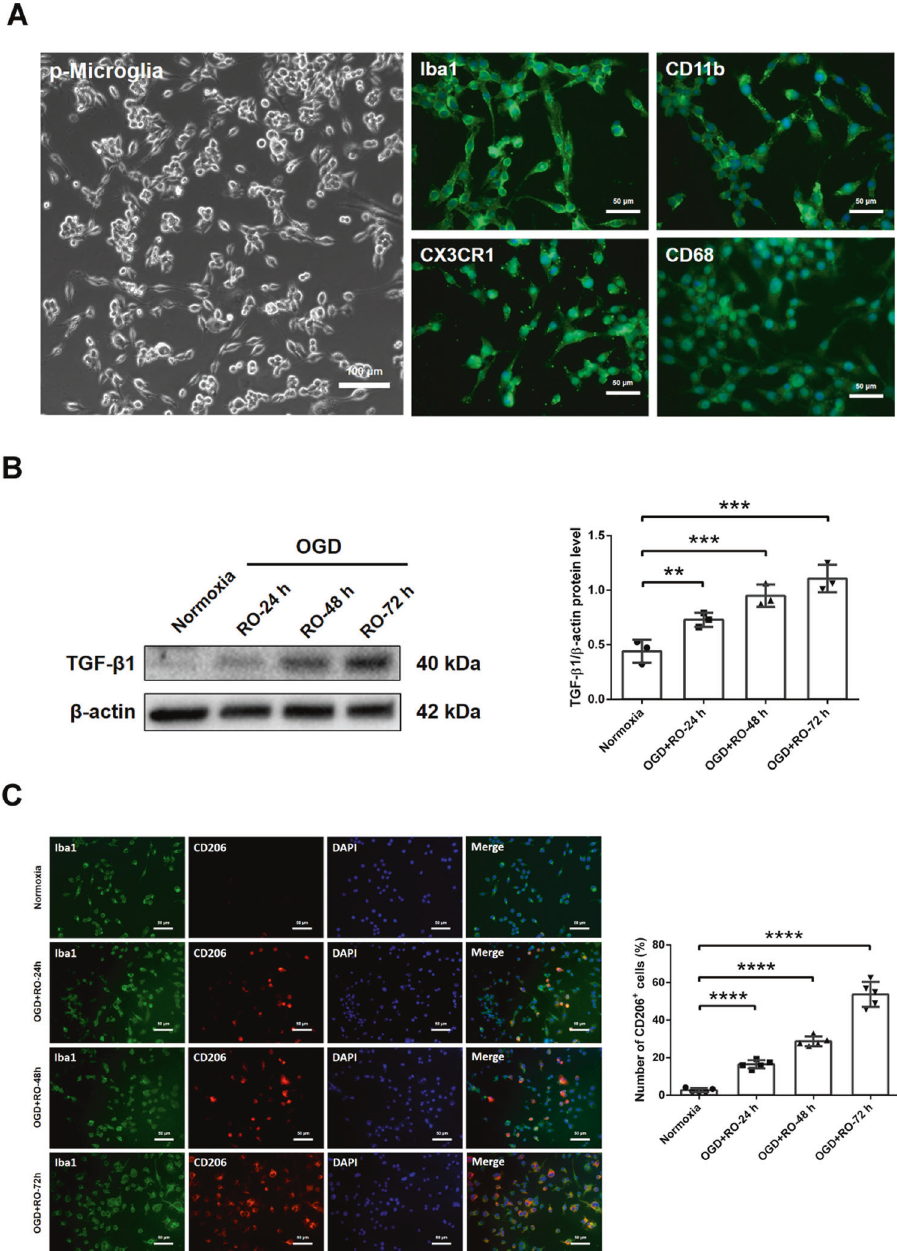
Fig. 1 In vitro oxygen − glucose deprivation (OGD) induces upregulation of TGF- β 1 and stimulates M2 polarization in primary microglia cells. A Phase-contrast images of primary microglia cells under bright- fi eld microscopy and immuno fl uorescence stainings against